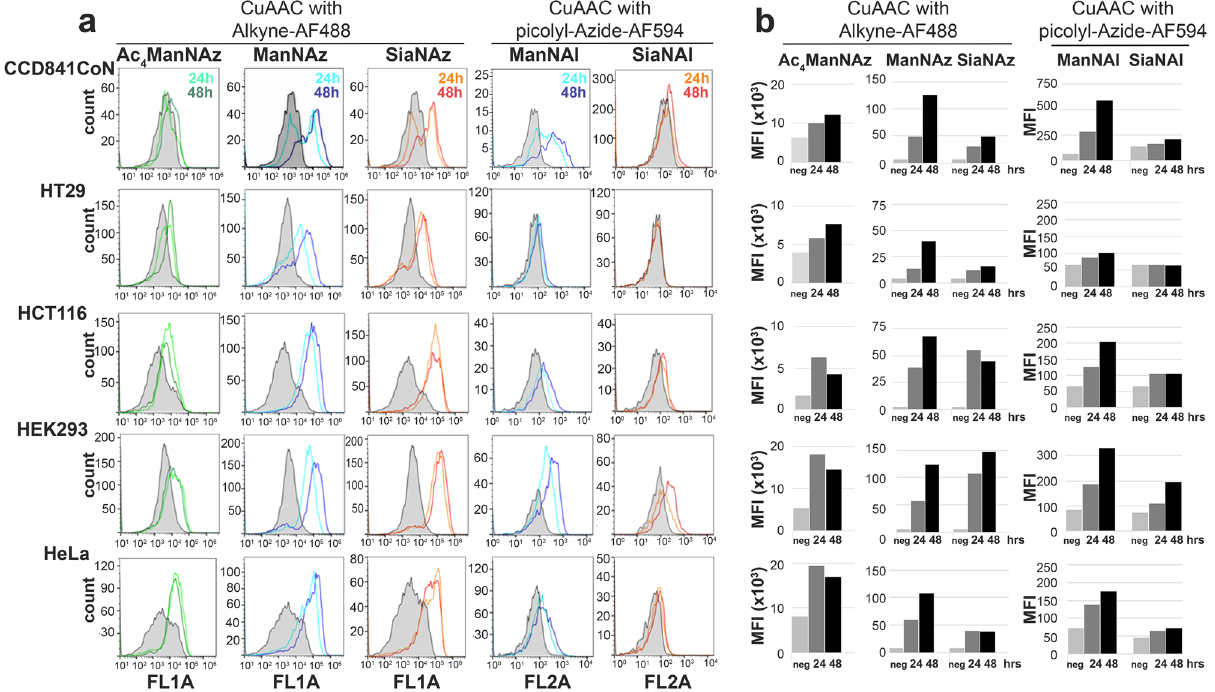
Figure 2. Flow cytometry analysis of labeled sialoglyconjugates at cell surface. Cells were incubated 24 h (in light color) or 48 h (in dark color) with the analogs before CuAAC using the appropriate fluorescent probe. For the negative controls (in grey), CuAAC was performed on cells cultured with ManNAc. ( a ) Flow cytometry histograms and ( b ) histograms showing the mean of fluorescent intensity (MFI). Results are representative of three